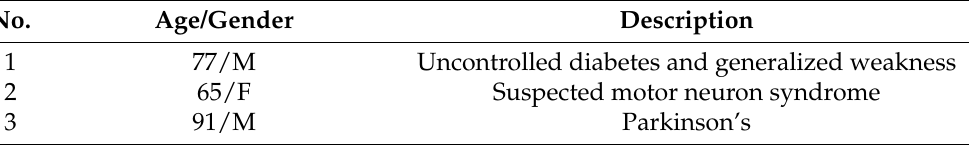
Table 2. Patient description.